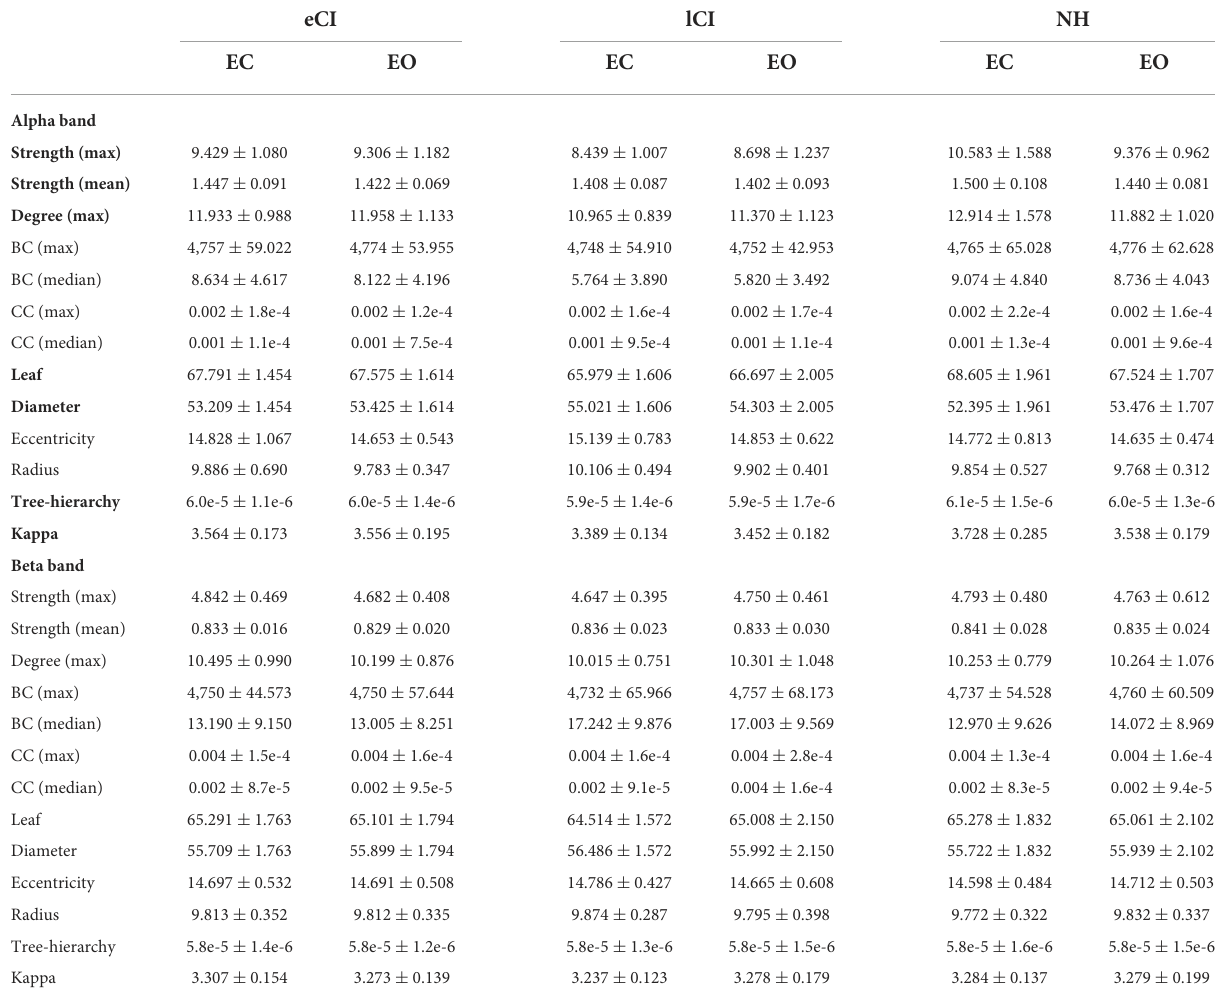
TABLE 5 MST metrics on Alpha and Beta bands of the children with early cochlear implantation (eCI), children with late cochlear implantation (lCI) and normal hearing children (NH) in eyes-open condition (EC) and eyes-closed condition (EO).